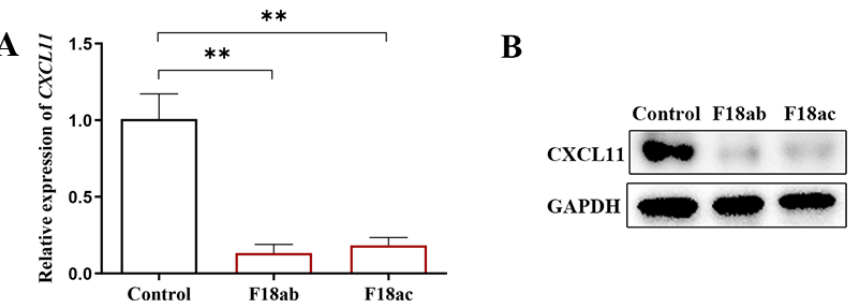
Figure 1. Differential expression analysis of the pig CXCL11 gene between E. coli F18-infected IPEC-J2 cells and E. coli F18-uninfected IPEC-J2 cells. ( A ) qPCR detection, ** p < 0.01. ( B ) Immunoblot analysis. Original Images for Blots are in Supplementary Materials.